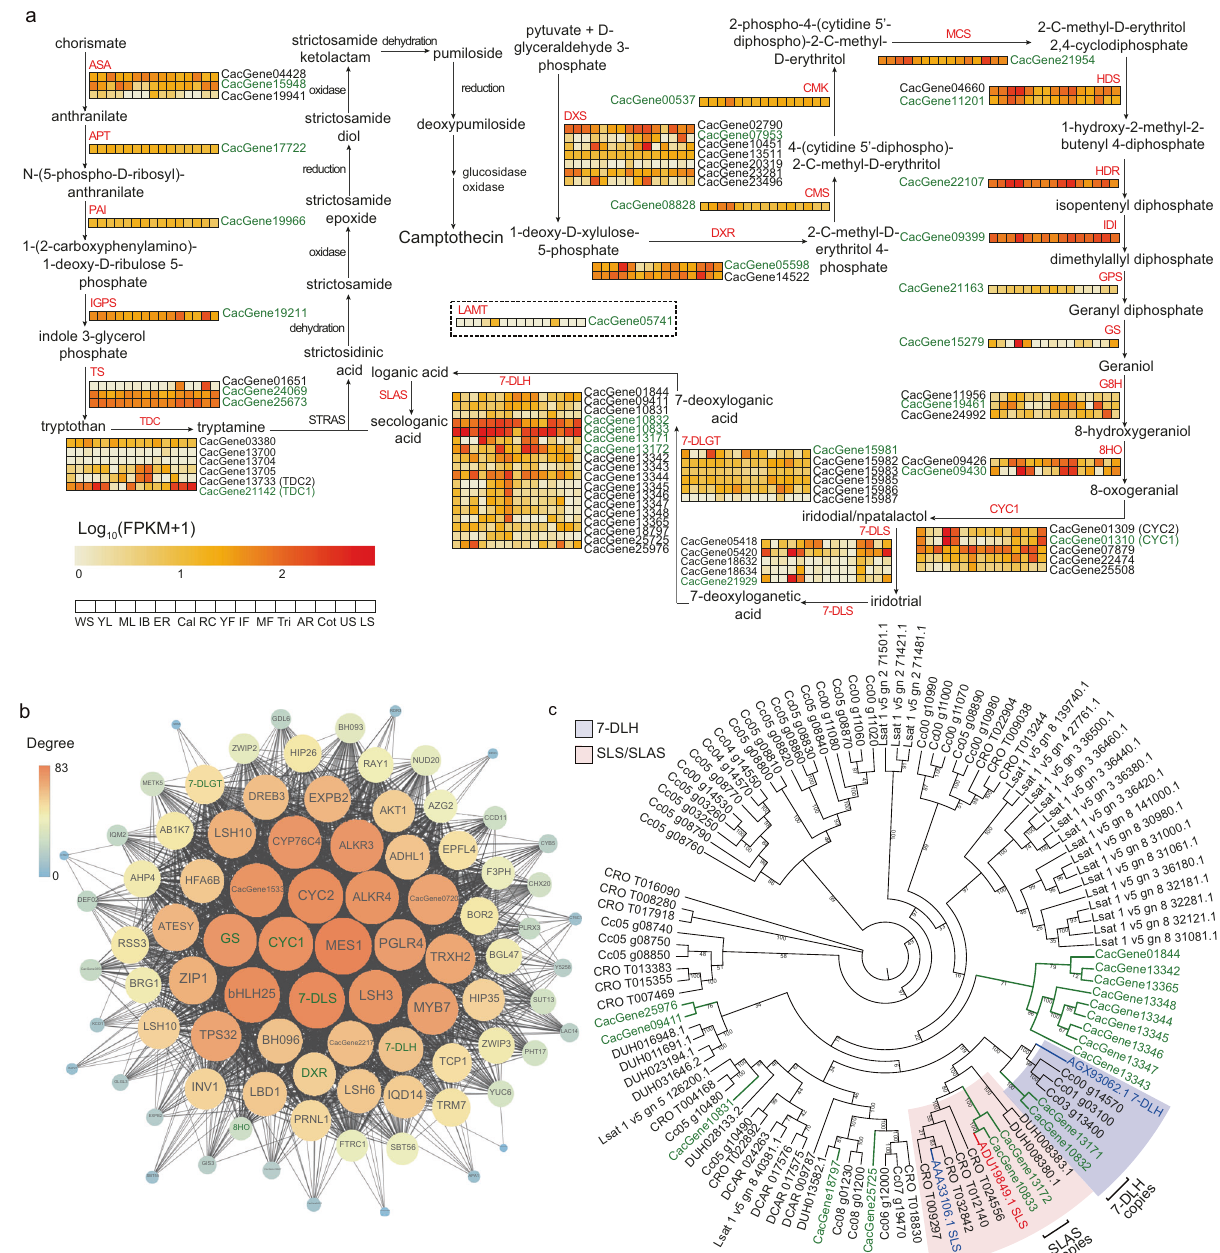
Fig. 2 Genes involved in camptothecin biosynthesis. a A simpli fi ed representation of the camptothecin biosynthetic pathway. Top hits for pathway genes identi fi ed by blast and pathway genes in the co-expression network are highlighted in green. The expression value for each gene is indicated in color on a log 10 (FPKM + 1) scale for fi fteen tissues: whole seedlings (WS), young leaf (YL), mature leaf (ML), immature bark (IB), entire root (ER), callus (Cal), root culture (RC), young fl ower (YF), immature fruit (IF), mature fruit (MF), trichomes (Tri), advance roots (AR), cotyledons (Col), upper stem (US), lower stem (LS). b The WGCNA “ grey60 ” module related to camptothecin biosynthesis as represented by a node and edge graph. Connection strength is represented by edge width (edge weights< 0.25 are omitted). c A phylogenetic tree of all candidate genes in the CYP72A subfamily. The sequences shown in blue and red indicate previously published 7-DLH and SLS genes in C. roseus while those in green show candidate genes identi fi ed in the C. acuminata V3.0